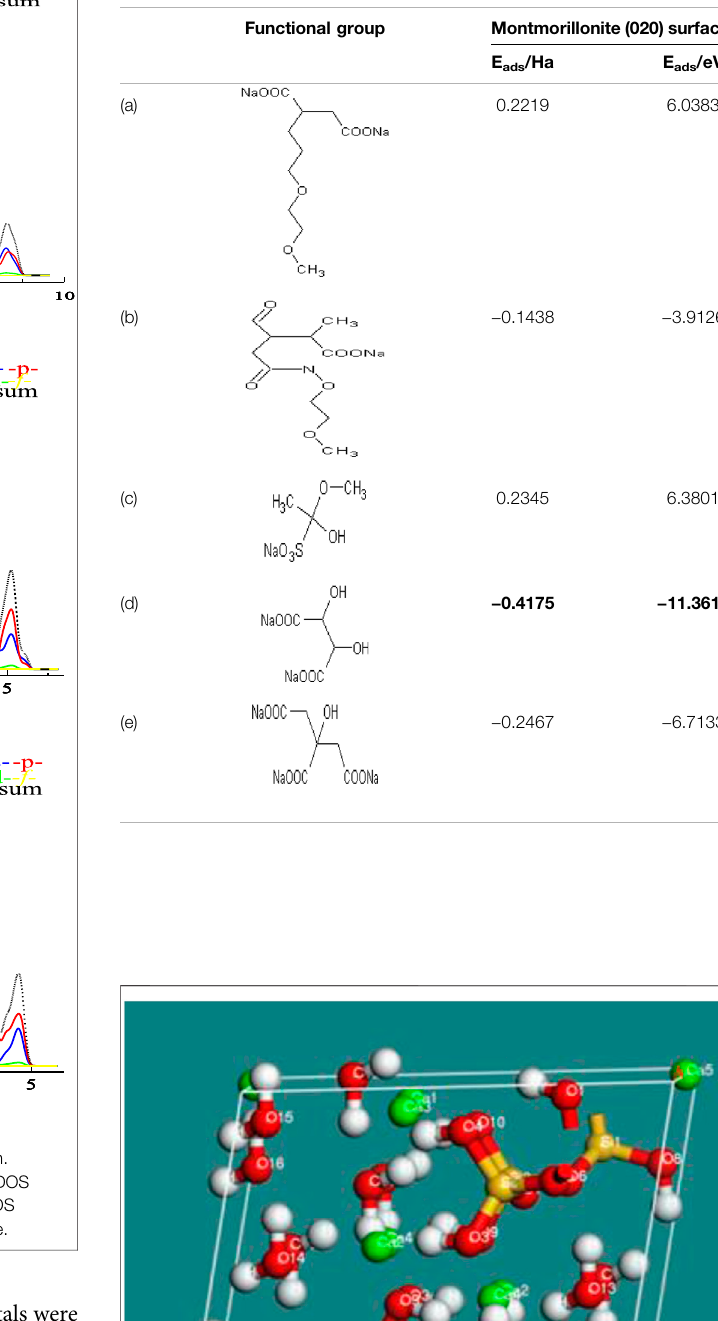
TABLE 4 | Calculations of the adsorption energy between the different additives and montmorillonite.